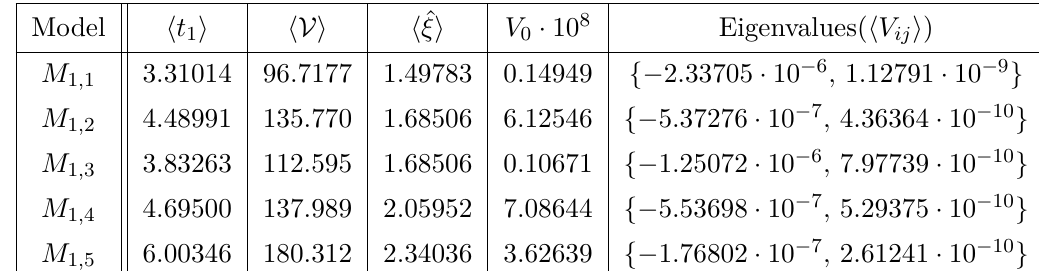
Table 8 . For all CICYs with h 1 , 1 = 1 , we present the α 0 -uplifted tachyonic dS vacua lying in a relatively larger volume regime. The underlying parameters are set as W